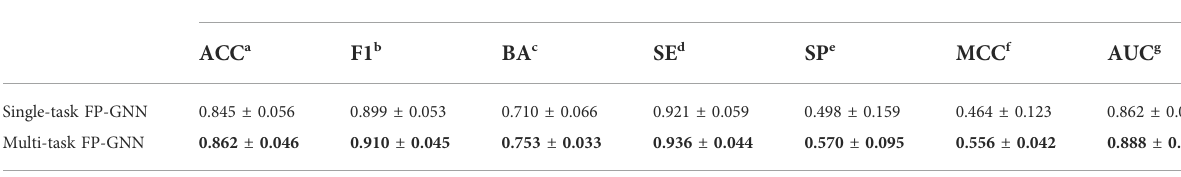
TABLE 4 The overall predictive performance of the single-task FP-GNN and multi-task FP-GNN model.